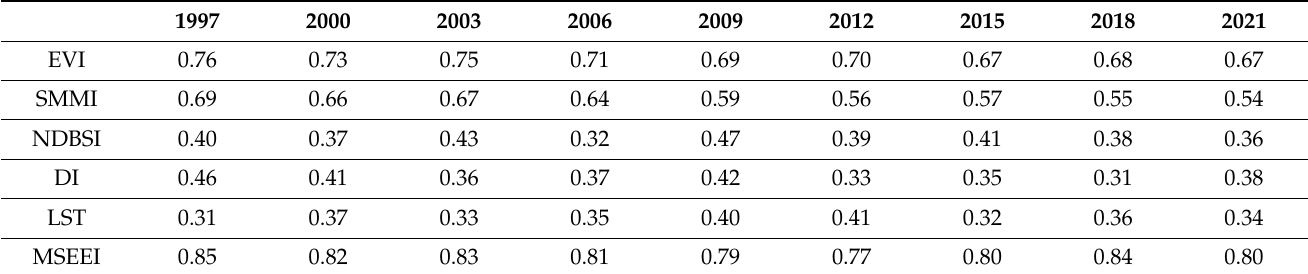
Table 2. Mean values of normalized ecological environment factors.